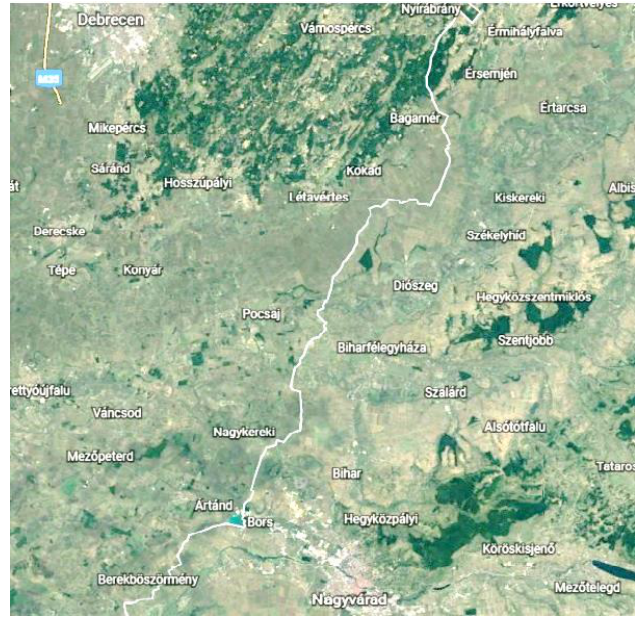
Figure 2. Territory of Érmellék wine region on Google map (I-1) Vineyards of the free royal